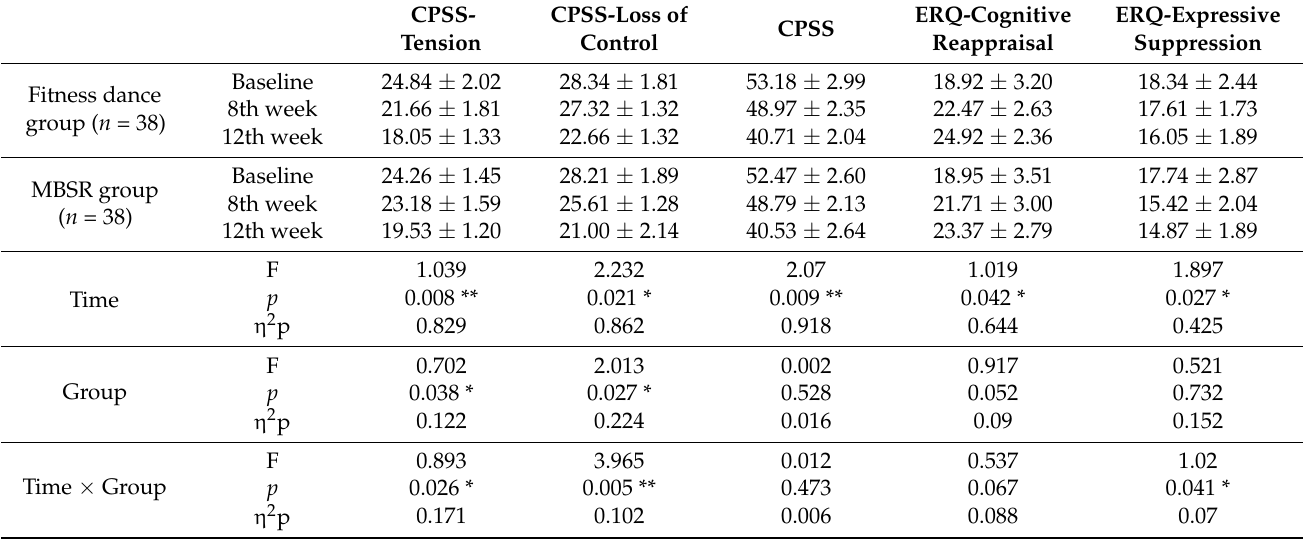
Table 3. Comparison of perceived stress and emotion regulation changes between the two groups before and after intervention (M ± SD).